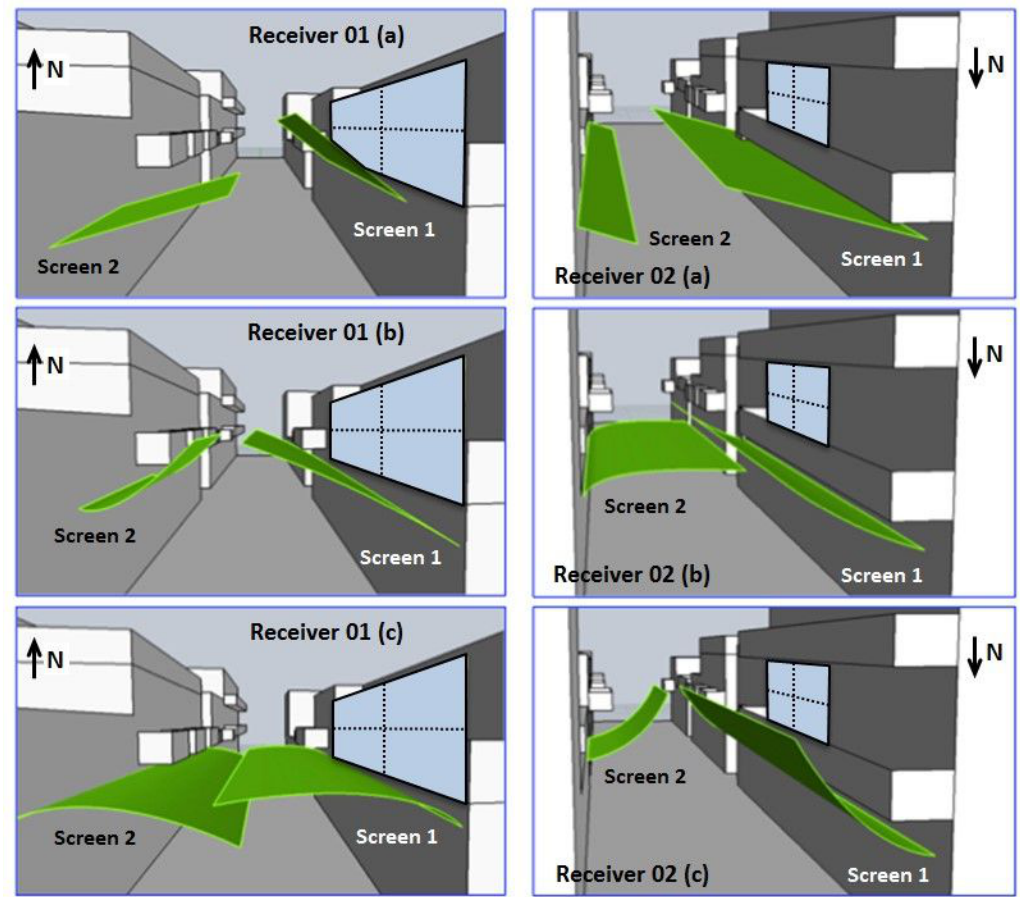
Figure 12: 3D view of the best configurations for linear (a), parabolic (b) and logarithmic spiral (c) screens in relation to Receiver 01 (on the left) and Receiver 02 (on the right)